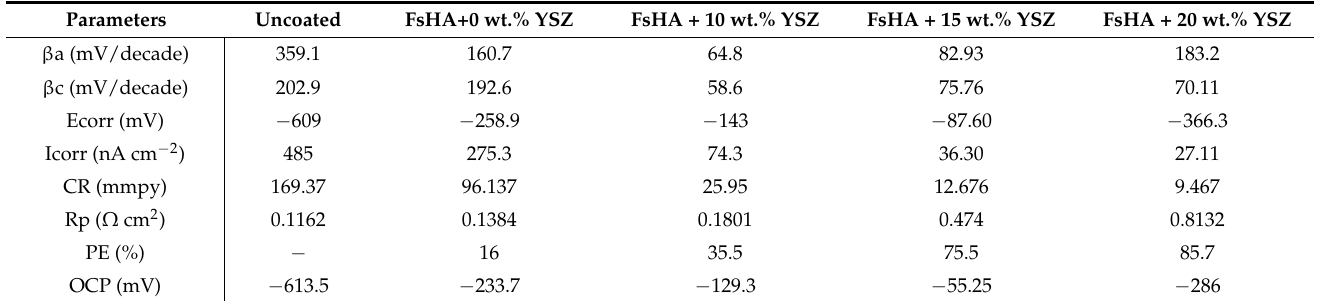
Figure 9. Potentiodynamic scans of ( a ) uncoated Ti–6Al–4V substrate, ( b ) FsHA + 0 wt.% YSZ coating, ( c ) FsHA + 10 wt.% YSZ coating, ( d ) FsHA + 15 wt.% YSZ coating, and ( e ) FsHA + 20 wt.% YSZ coating. Table 4. Potentiodynamic test results.